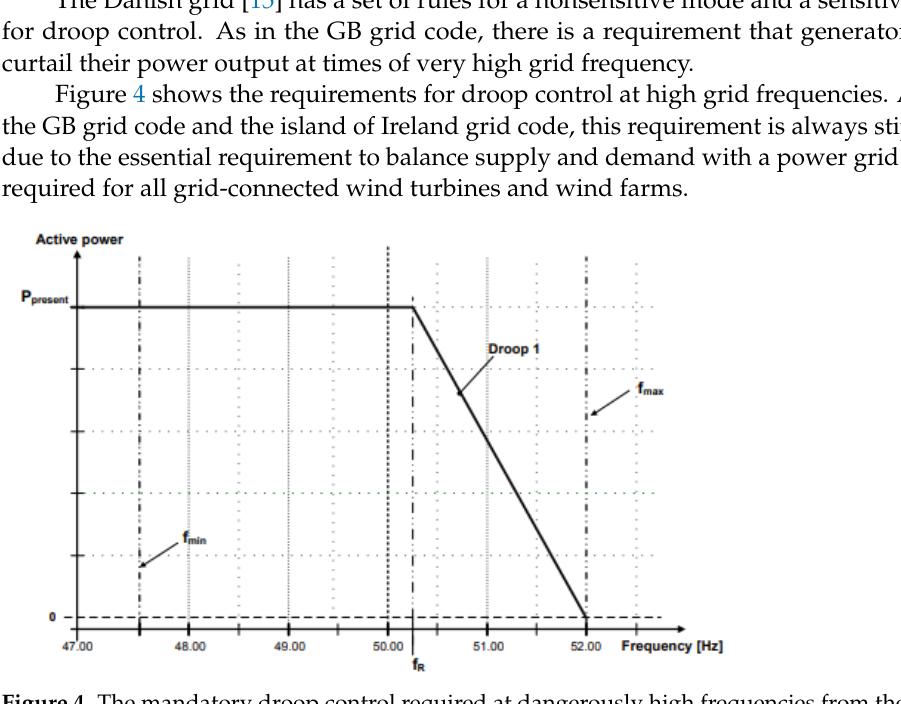
Figure 4. The mandatory droop control required at dangerously high frequencies from the Danish grid code